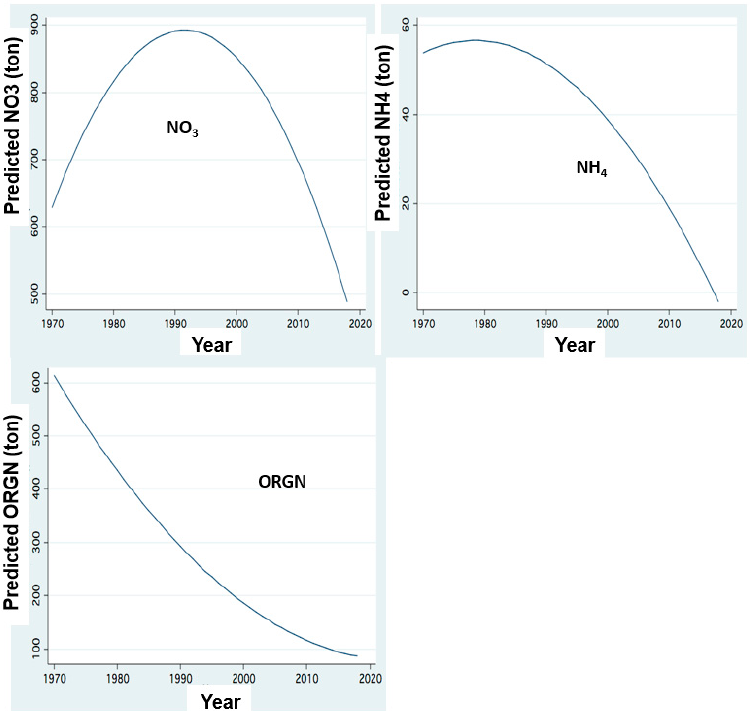
Figure 8. Temporal changes of N loads: FP regression between annual (1970–2018) Load inputs (ton) through Jordan discharge of Nitrate (NO 3 ), Ammonium (NH 4 ), and Organuc Nitrogen (ORGN)Nitrogen and years.